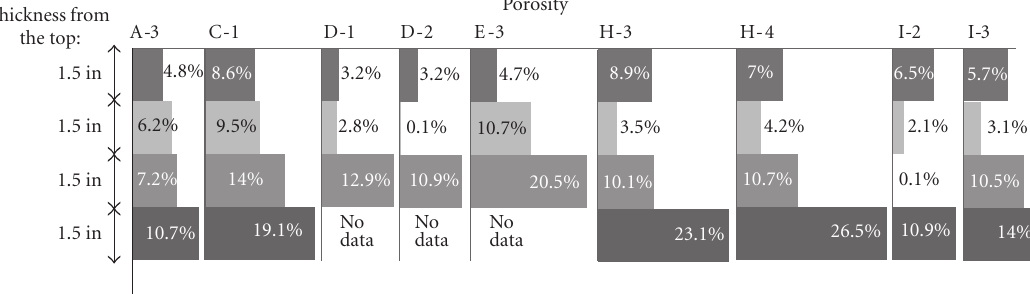
Figure 7: Porosity of nine concrete samples with respect to core depth determined by volumetric method.